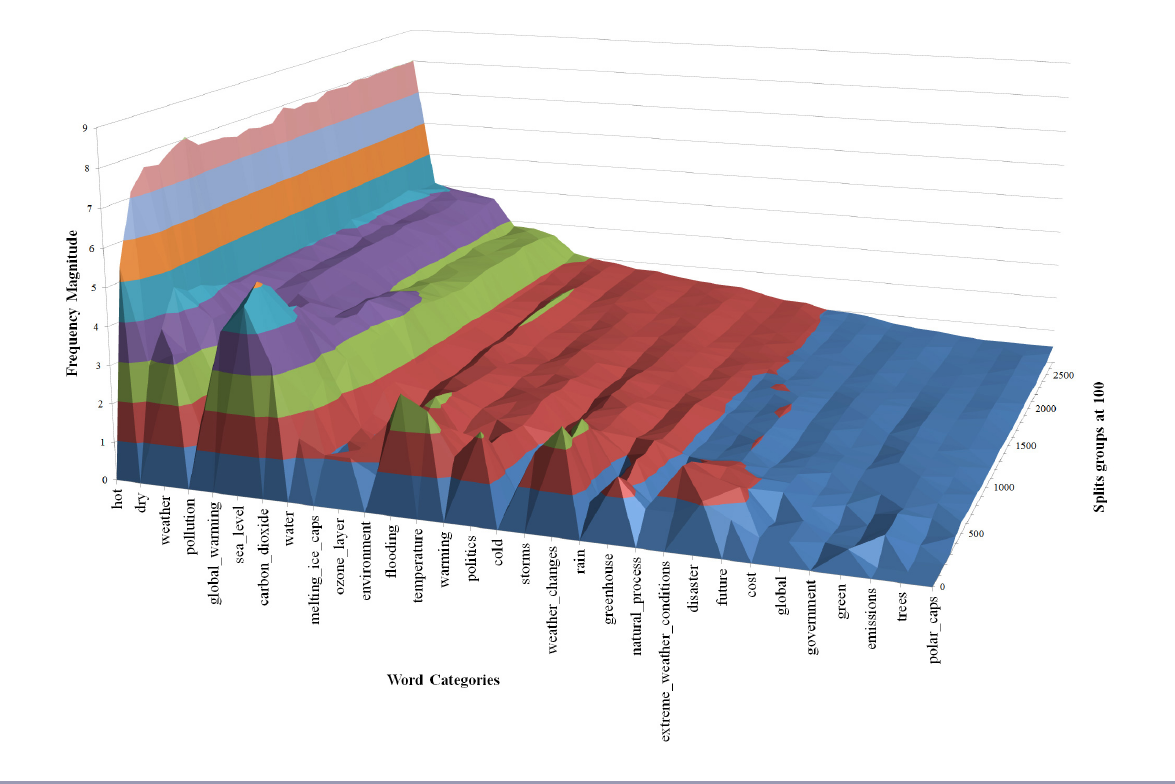
Fig. 1. A split plot for the first 31 most frequently occurring word categories associated with climate change for three respondent groups: scientists/academics/researchers, government employees, and community members. Categories are ordered by frequency magnitude across all three